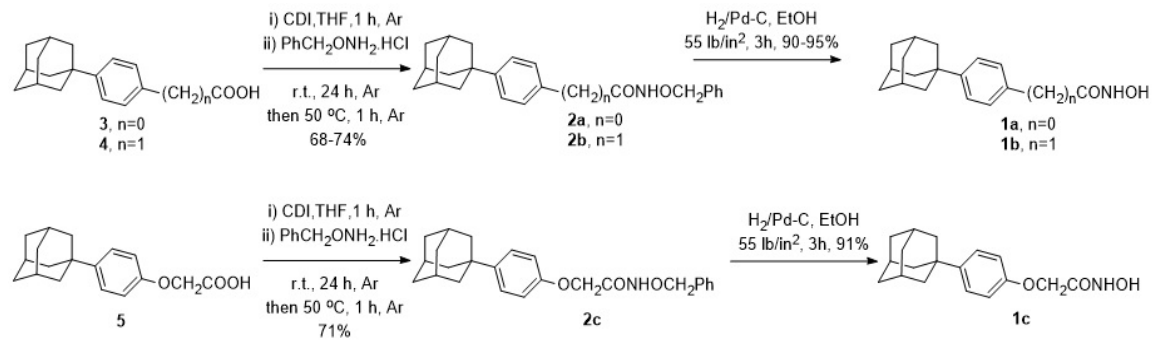
Table 1. Anti- T. brucei screening of derivatives 1a – c